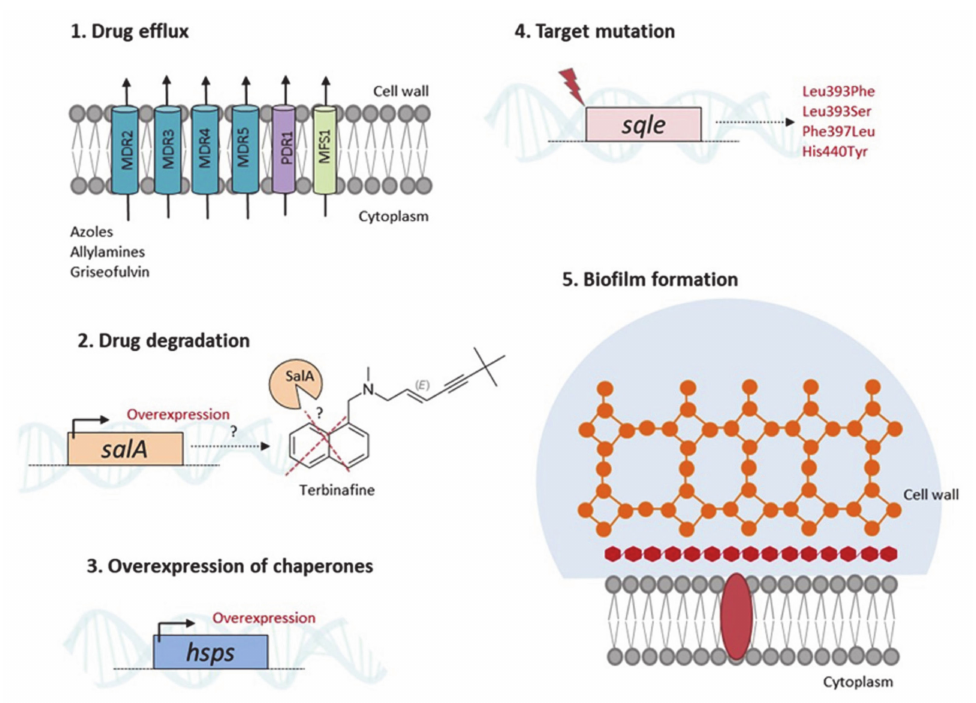
Figure 3. Antifungal resistance mechanisms described in